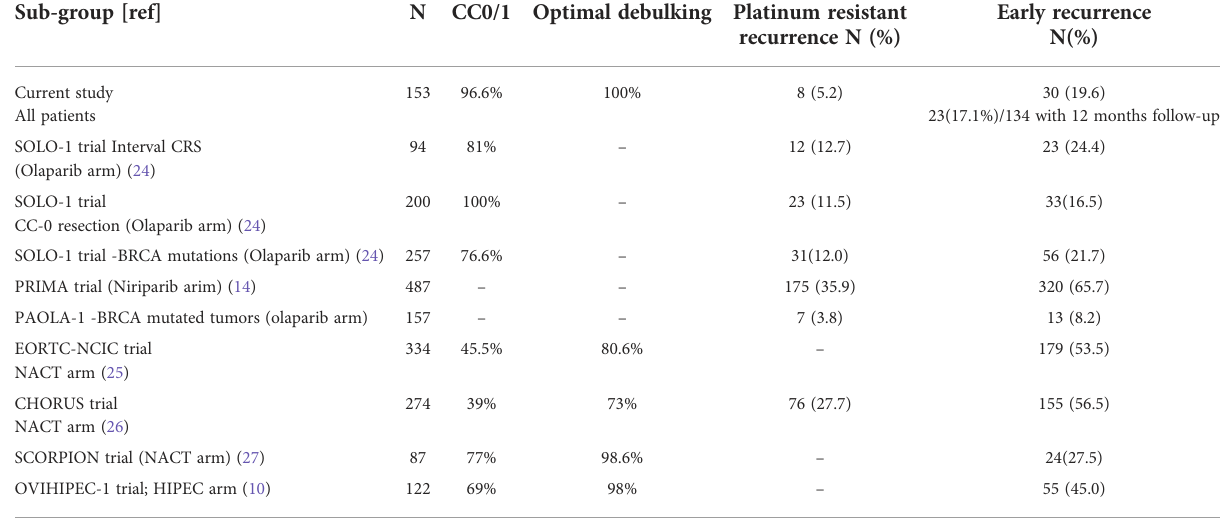
TABLE 5 Platinum resistant recurrence and early recurrence observed in the current study and that reported in published